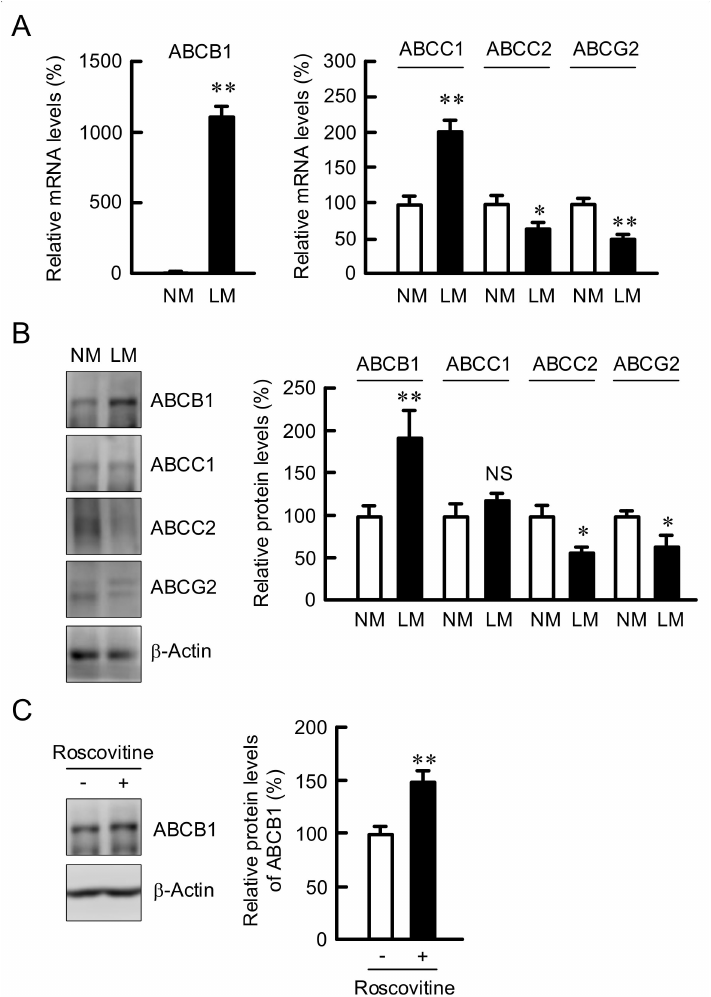
Figure 5. Increase in the expression of ABCB1 by LM and roscovitine. ( A ) A549 cells were continu- ously cultured in the media containing NM or LM. Real-time PCR was performed using primer pairs for ABCB1, ABCC1, ABCC2, ABCG2, and β -actin. The mRNA levels are represented in percentage to NM. ( B ) Western blotting was performed using anti-ABCB1, anti-ABCC1, anti-ABCC2, anti-ABCG2, and anti- β -actin antibodies. The protein levels are represented in percentage to NM. ( C ) The cells cultured in the NM medium were incubated in the absence and presence of 10 µ M roscovitine for 24 h. After Western blotting with anti-ABCB1 and anti- β -actin antibodies, the protein levels are represented in percentage to the cells without roscovitine. n = 3–4. ** p < 0.01 and * p < 0.05 compared with NM or -roscovitine. NS, p >